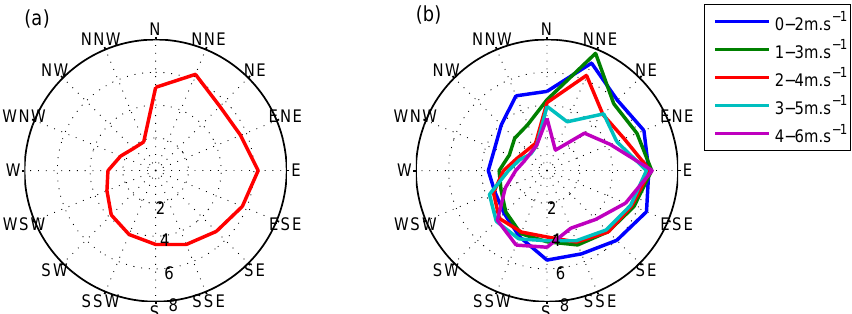
Figure 13. (a) Wind rose showing the SO 2 VCD (10 16 moleccm − 2 ) as a function of the wind direction (average for all wind speed). (b) Dependence of SO 2 VCD (10 16 moleccm − 2 ) on wind direction for different wind speeds.